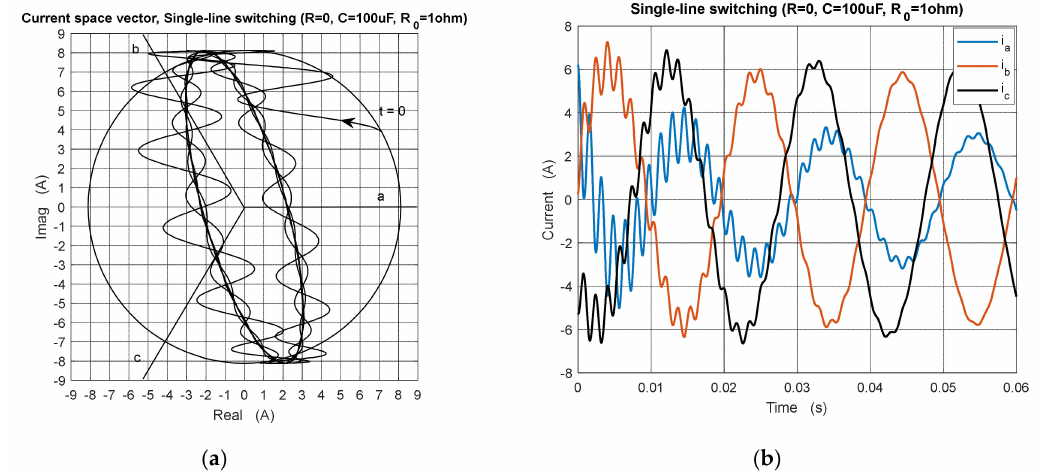
Figure 14. Single-line switching of phase a . Time-behavior of the current space vector ( a ) and the related phase currents ( b ) for the three-phase circuit in Figure 10 where S operates single-line switching of phase a with an impedance Z consisting of a capacitor C = 100 µ F. The single-phase circuit consists in R 0 = 1 Ω